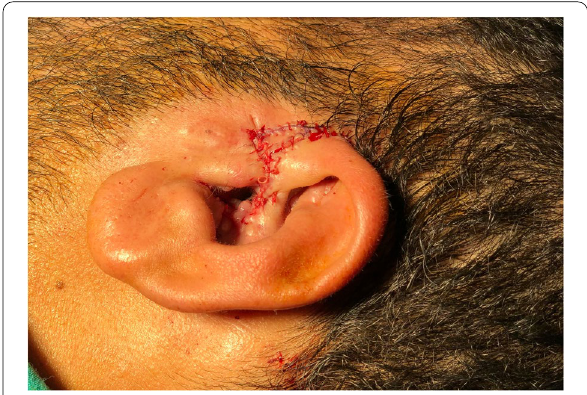
Fig. 3 External auditory canal patency and adapted preauricular fasciocutaneous island flap